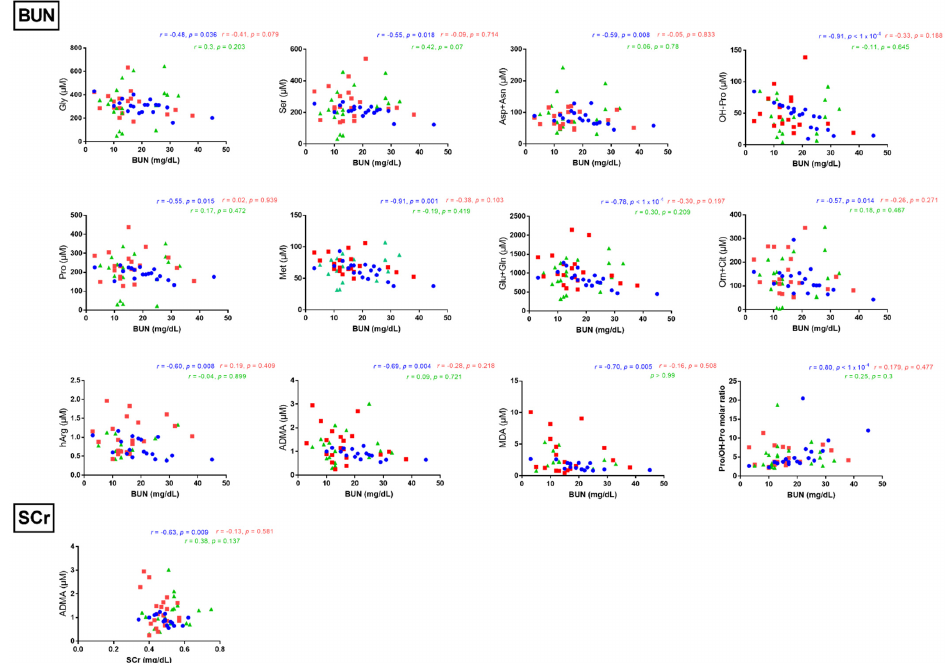
Figure 4 . Illustration of statistically significant correlations ( r > 0.4, p < 0.05) found between blood urea nitrogen (BUN) or serum creatinine (SCr) and the serum concentrations of indicated metabolites in Group A (surgical treatment). Spearman correlation was performed in all comparisons.